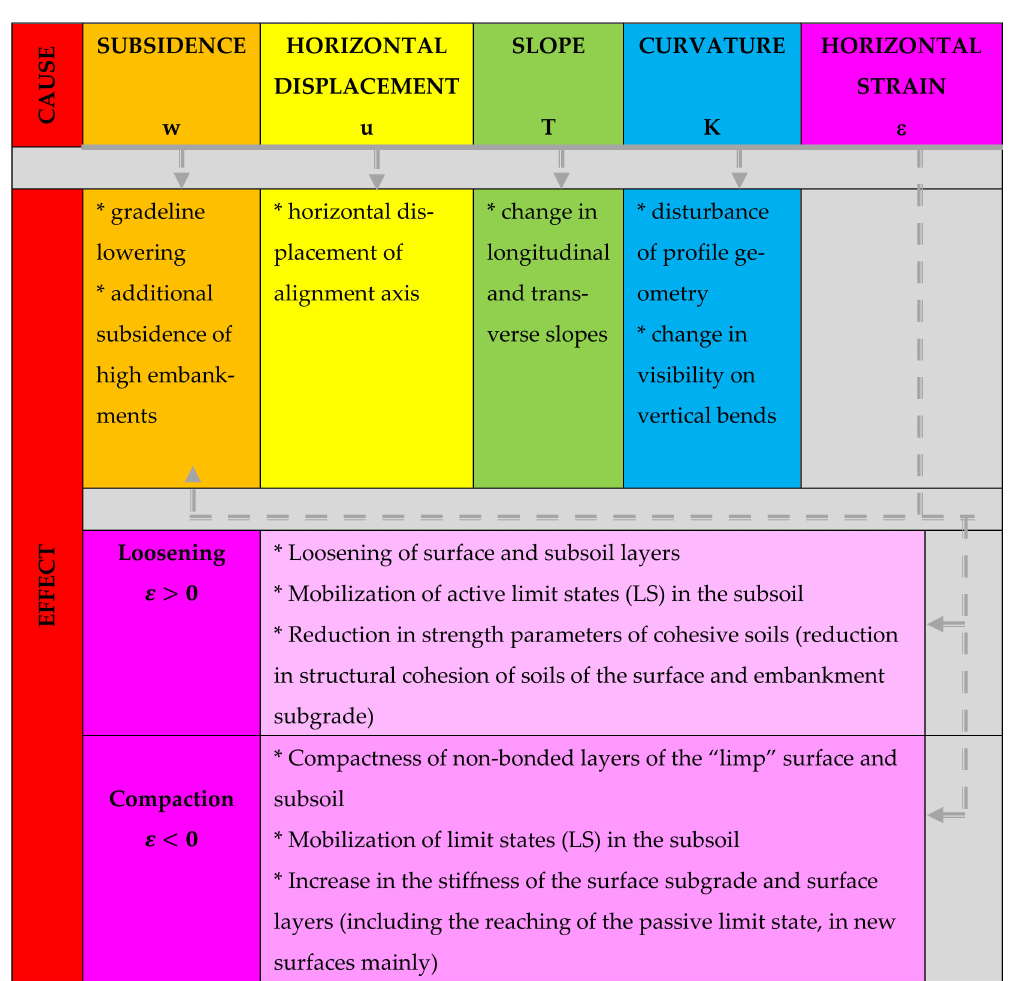
Figure 2. Deformation of the surface of the analysed land properties by factors affecting the characteristic of the range of mining impacts. Fixed mining trough in a plane deformation state: β —value of the main influence range angle; w max — maximum lowering of the mining trough (m); g—thickness of the selected layer (m); a—service factor for w max = a · g